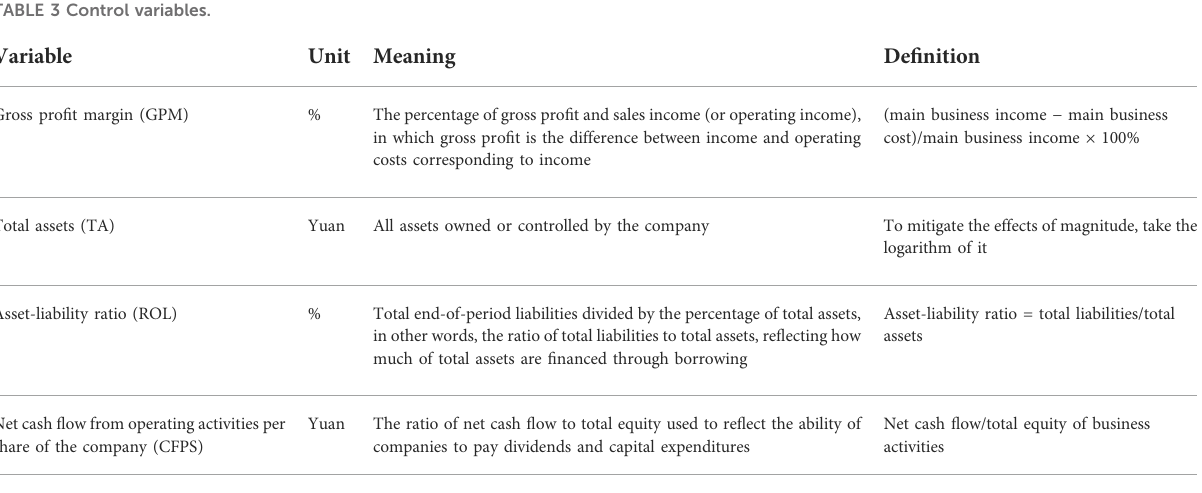
TABLE 3 Control